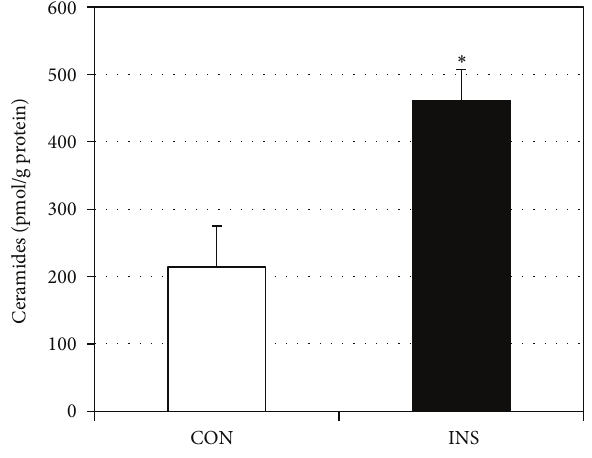
Figure 1: Murine myotubes were treated with vehicle (CON) or insulin (INS, 50nM) for 16h. Following treatment, ceramides were isolated and quantified. ∗ 𝑃 < 0.05